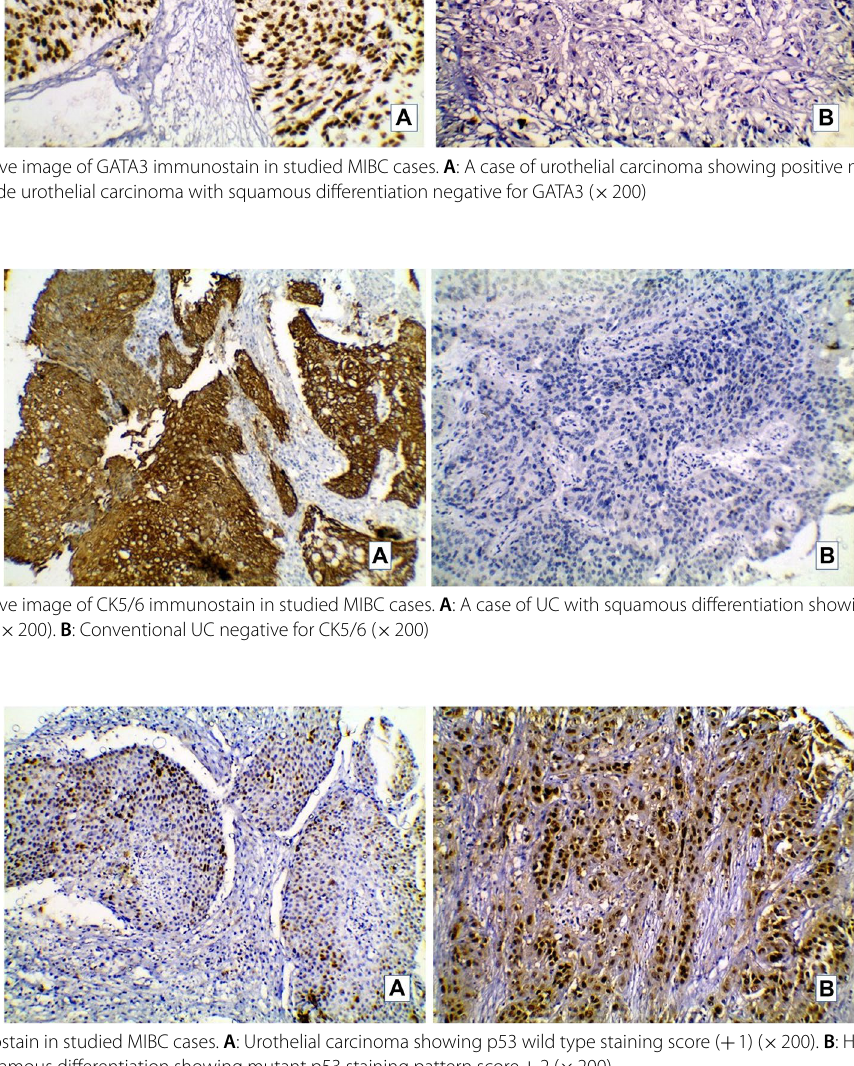
1) ( 200). B : High grade urothelial + ×